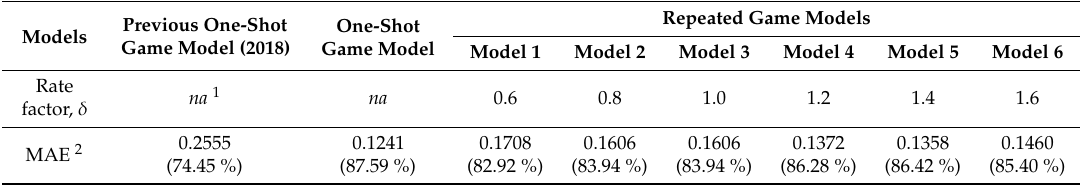
Table 3. Calibration Results.